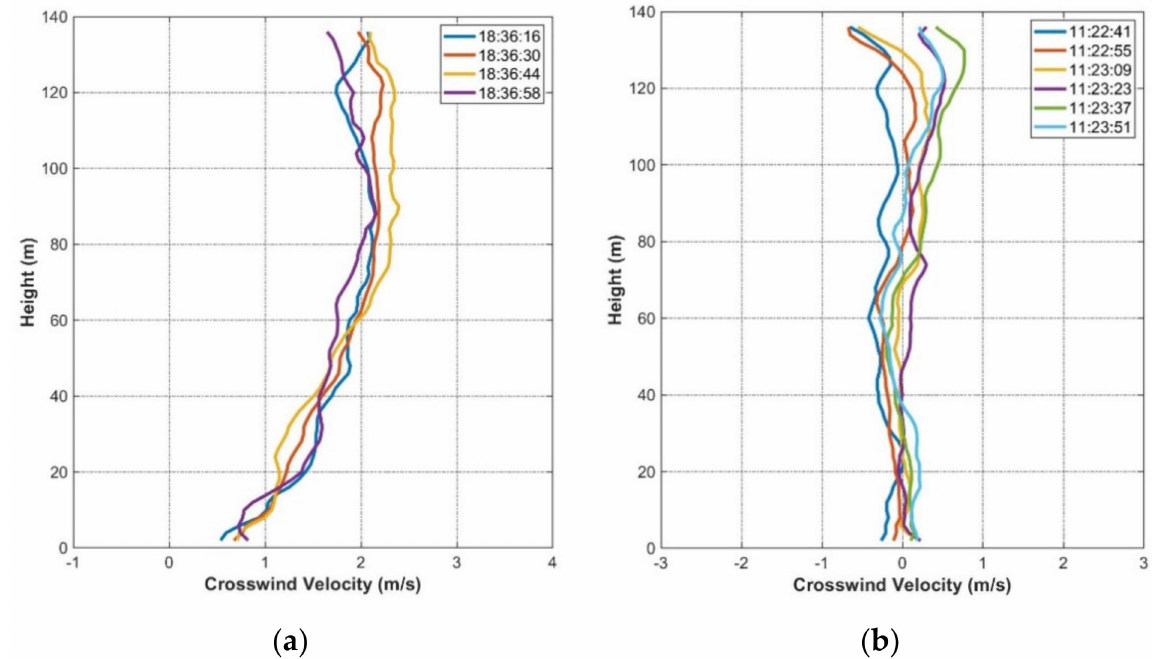
Figure 9. Crosswind profiles of PCDL RHI measurement. ( a ) Stronger crosswind: during 18:36:16~18:36:58 on 1 September 2018. ( b ) Gentle crosswind: during 11:22:41~11:23:51 on 27 August 2018.